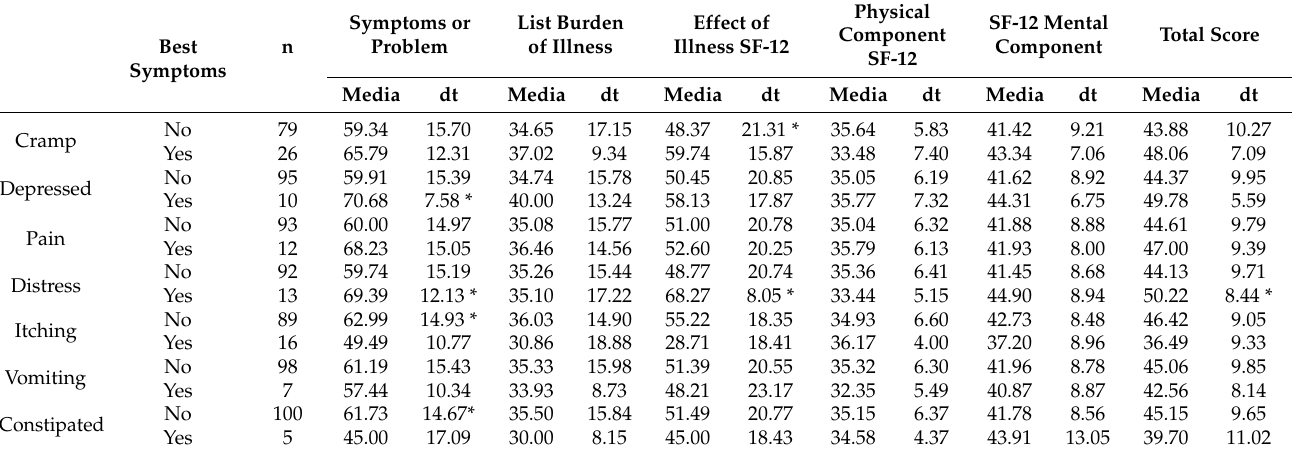
Table 5. Scores in the domains of the KDQOL-SF Scale, according to clinical improvement of